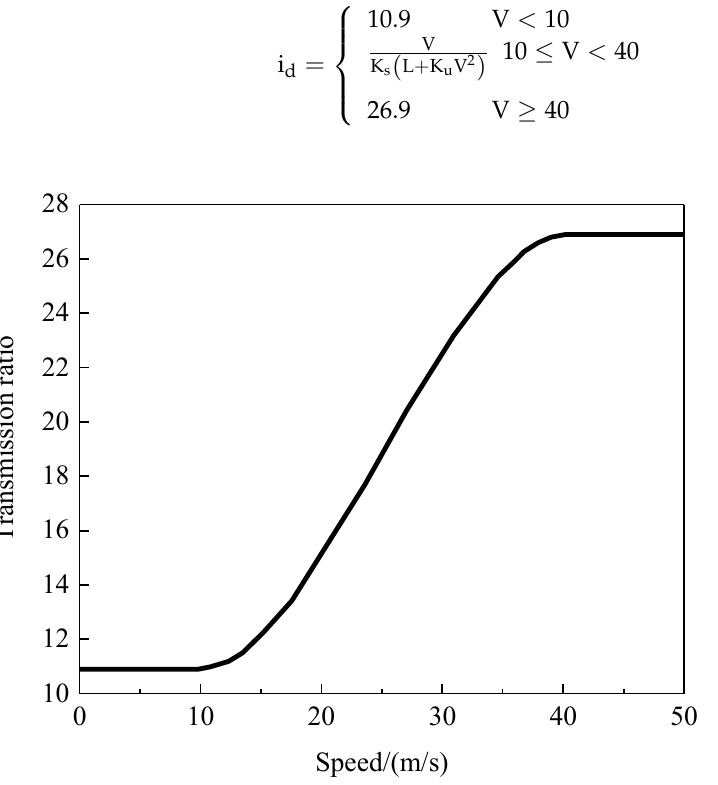
Figure 4. AFS variable transmission ratio rule.